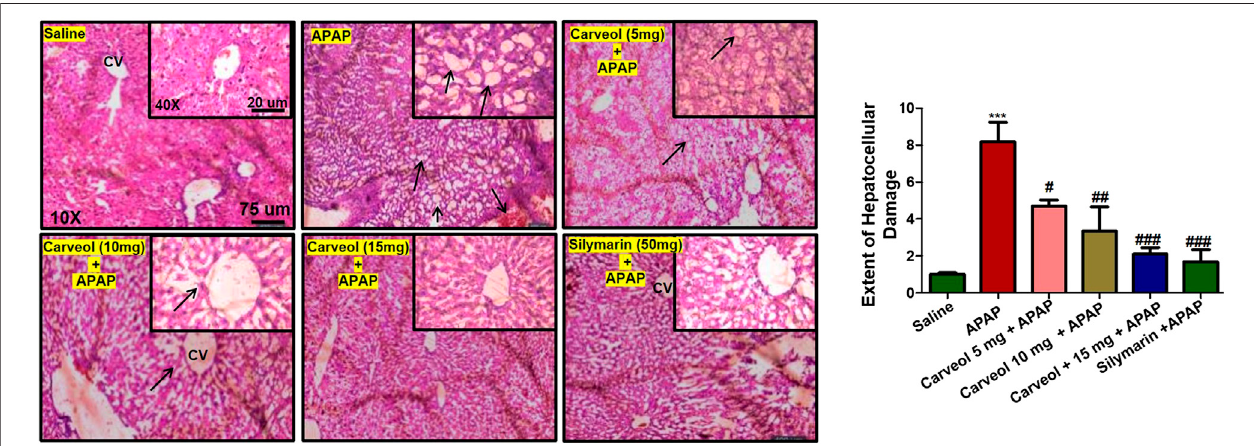
Figure 4 | Carveol restored the morphological integrity of the liver, as shown by histological examination. Liver tissue was stained with H and E (magni fi cation, × 10 scalebar75 μ mand40 × scalebar20 µm).Thedataarepresentedasmeans ± SEMandwereanalyzedusingone-wayANOVAfollowedbyTukey ’ smultiplecomparison